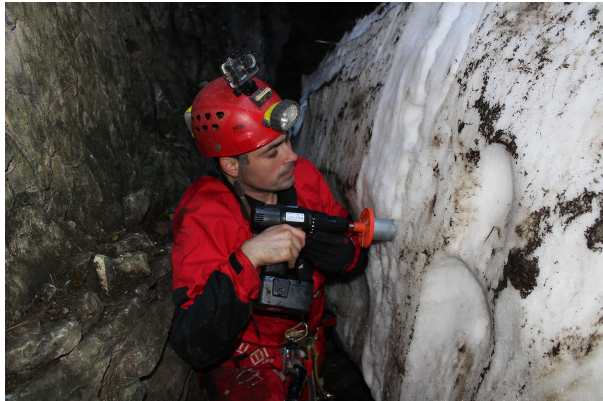
Figure 2. Sampling location and procedure in the Christaki